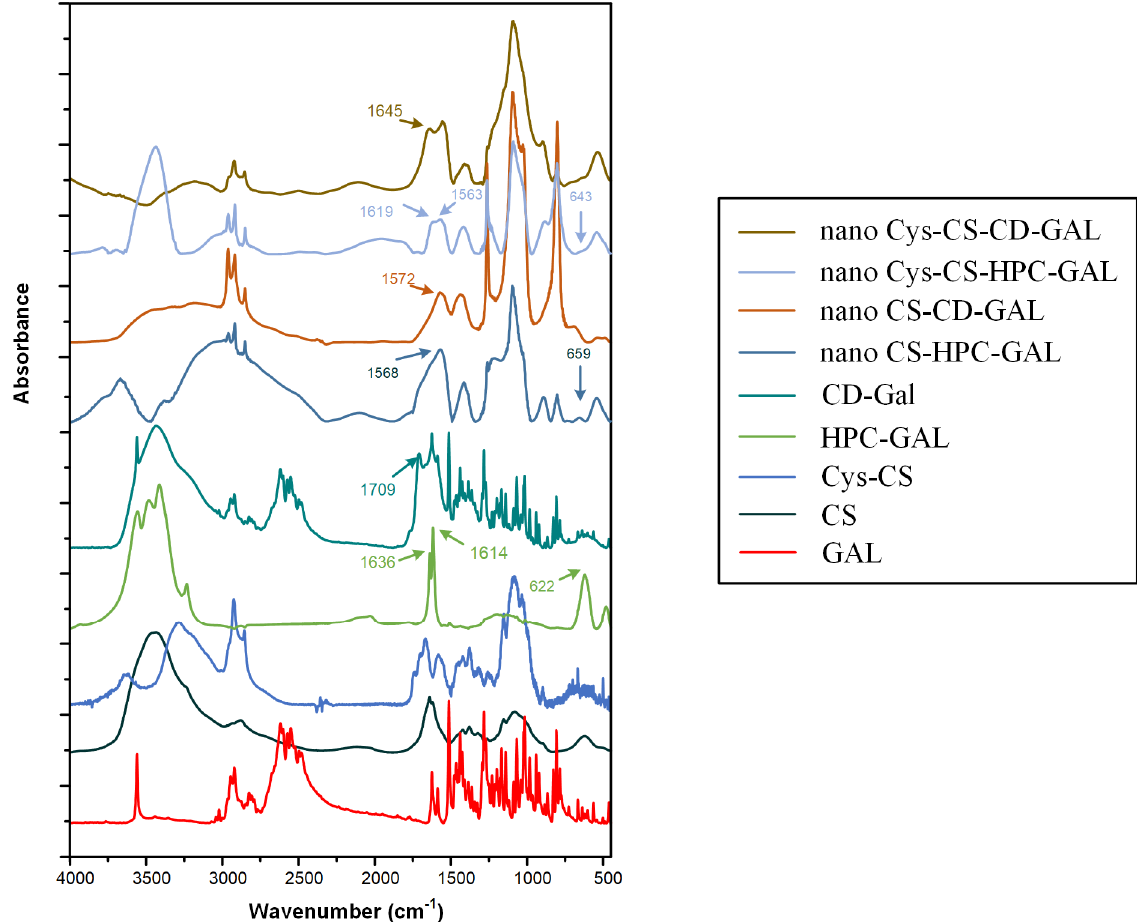
Figure 8. FTIR spectra of the raw materials and the prepared NPs.